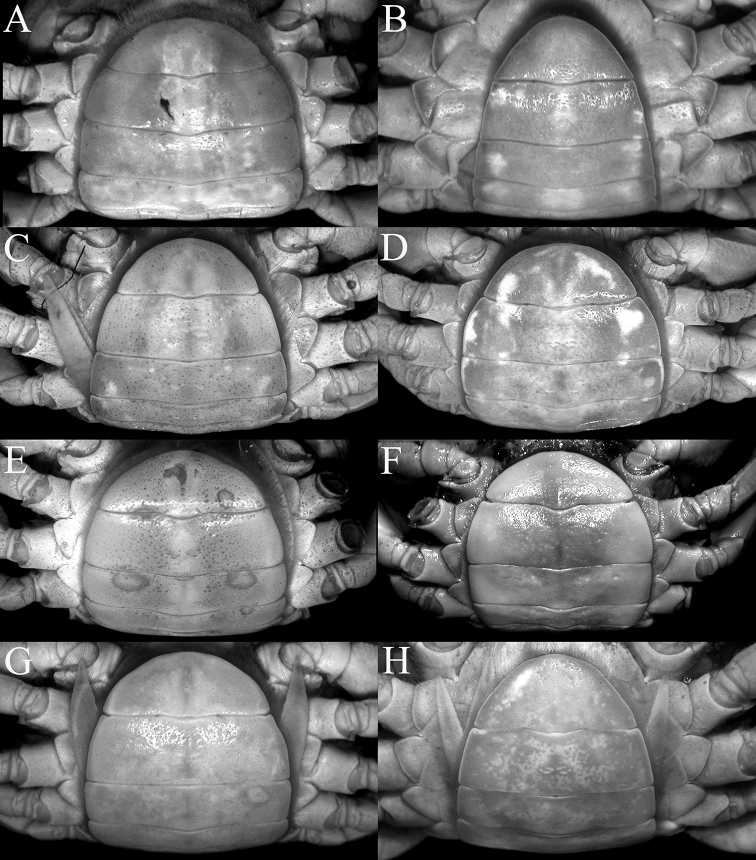
Female pleon AJohora
intermedia Ng, 1986, female (17.9 × 14.7 mm) (ZRC 2001.1002), Selangor BJ.
tahanensis (Bott, 1966), female (24.4 × 21.0 mm) (ZRC 1984.6765), Pahang CJ.
thoi Ng, 1990, female (31.7 × 25.5 mm) (ZRC 2001.1167), Terengganu DJ.
hoiseni Ng & Takeda, 1992, paratype female (22.1 × 19.0 mm) (ZRC 1984.6675), Kelantan EJ.
thaiana Leelawathanagoon, Lheknim & Ng, 2005, paratype female (21.0 × 17.4 mm) (ZRC 2006.0053), Thailand FJ.
booliati sp. nov., paratype female (40.4 × 34.4 mm) (ZRC 1995.270), Pahang GJ.
erici sp. nov., paratype female (32.8 × 26.9 mm) (ZRC 1995.268), Perak HJ.
michaeli sp. nov., paratype female (29.9 × 25.0 mm) (ZRC 2010.0047), Terengganu.